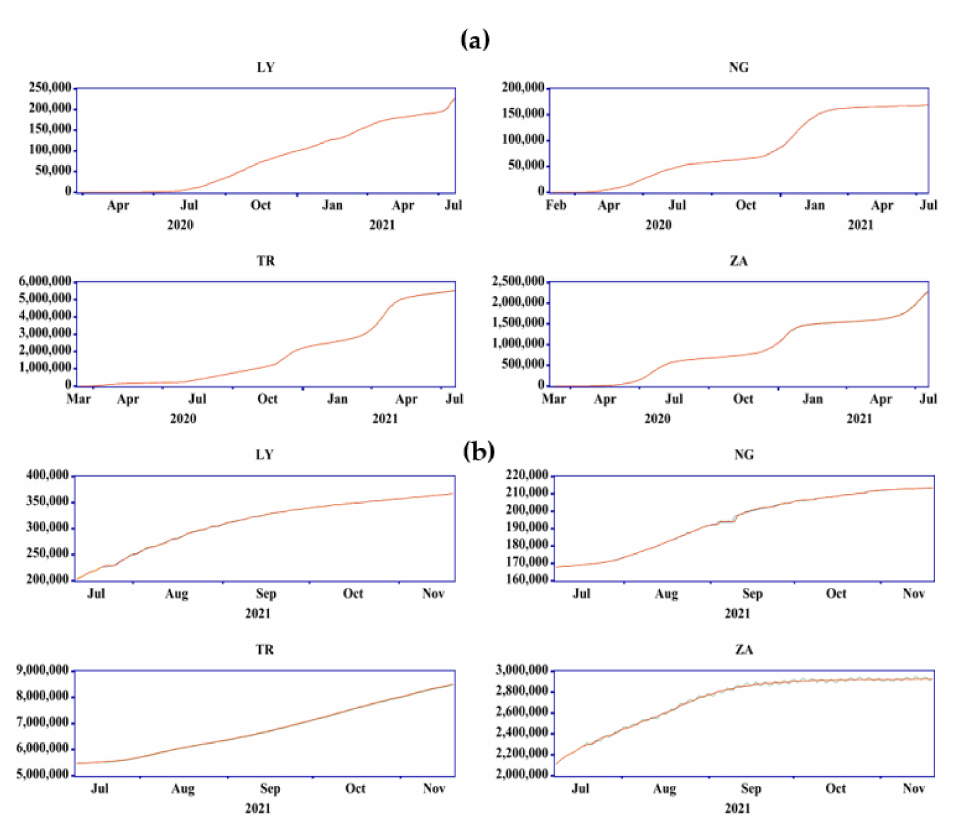
Figure 11. Forecast comparison graph for the: ( a ) training, and ( b ) testing samples.